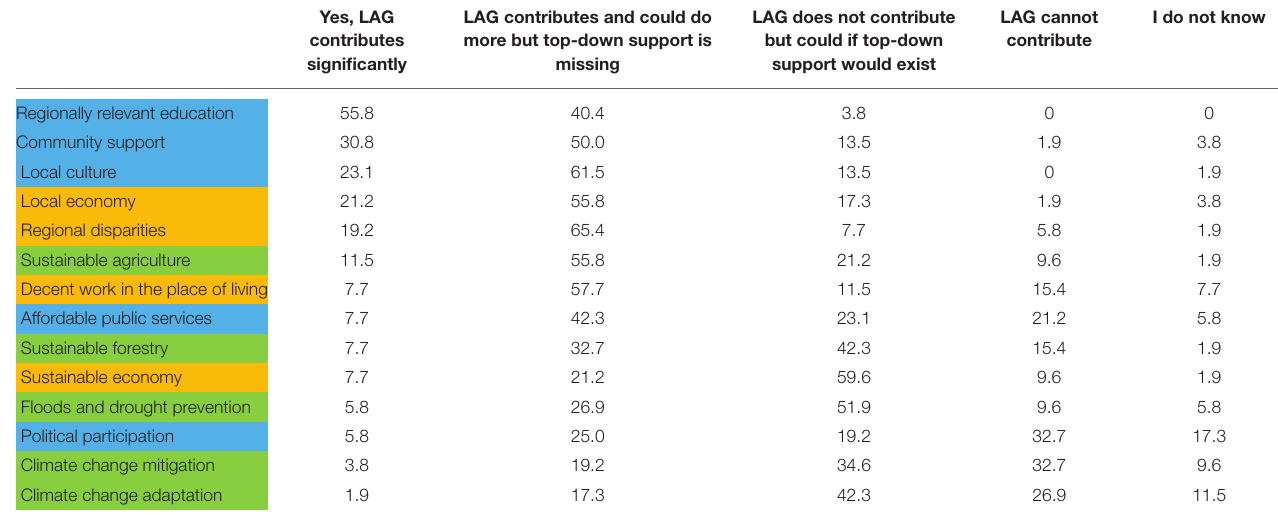
TABLE 1 | LAGs’ contribution to the fulfillment of Adapted SDGs (in